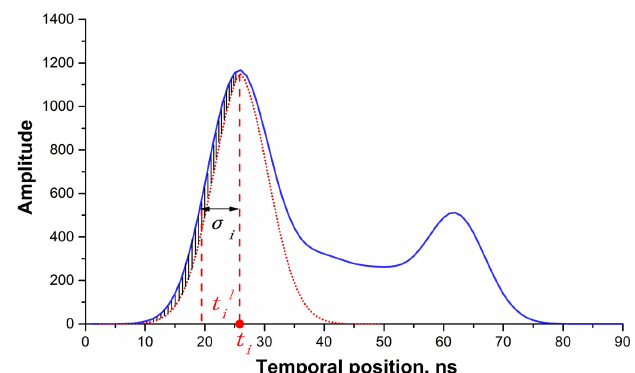
Figure 5. Waveform decomposition and parameter optimization based on the standard deviation of the left half of the waveform. The dashed red curve is the fitted Gaussian curve; the blue curve indicates the signal segment.